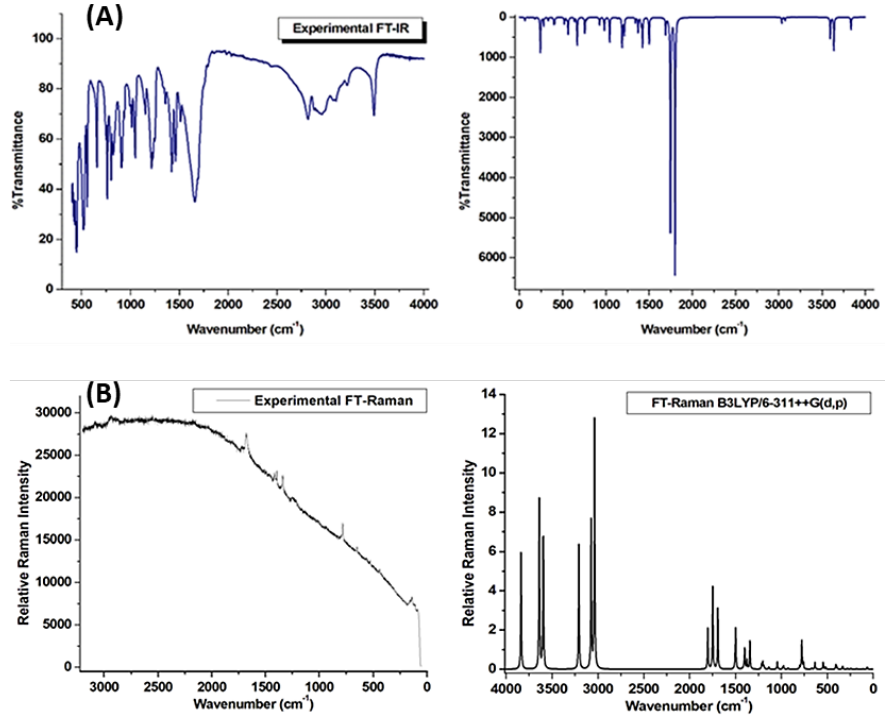
Figure 2 . Experimental and computational spectra of ( A ) FT-IR, and ( B ) FT-Raman. Figure 2. Experimental and computational spectra of ( A ) FT-IR, and ( B )